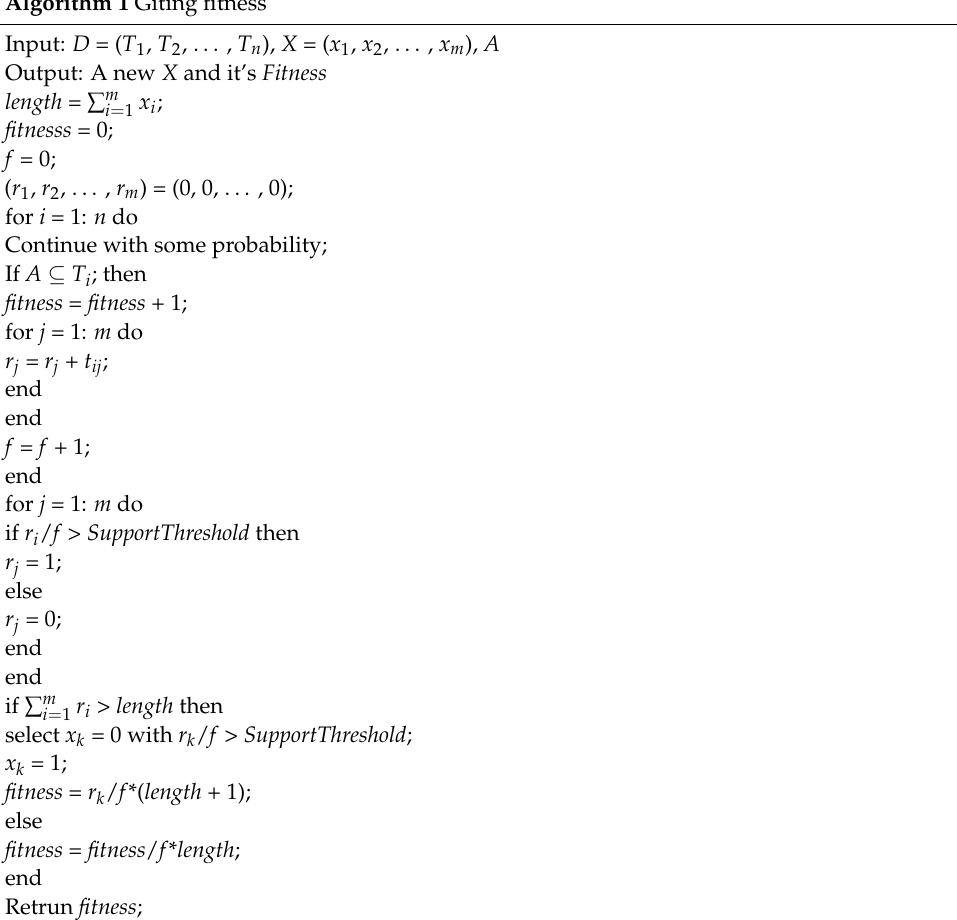
Algorithm 1 Giting